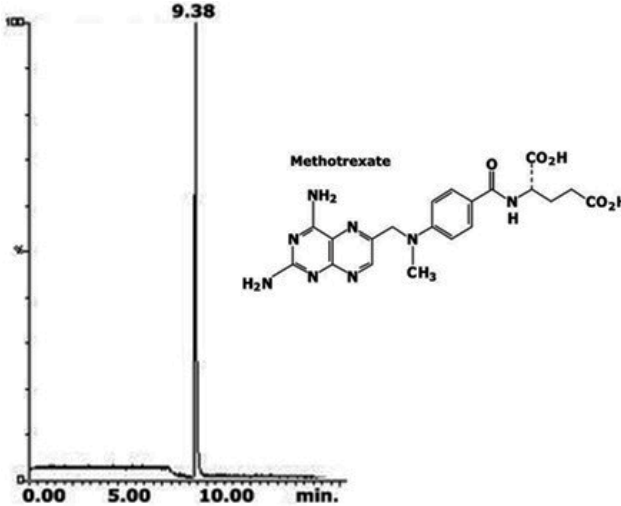
Figure 5. Analysis of methotrexate using a silica hydride C18 stationary phase in the aqueous normal phase mode. Mobile phase: A, DI H 2 O/0.5% formic acid and B, acetonitrile. Gradient: 0–1 min 90% B, 1–5 min to 20% B, 5–10 min 20% B. (http://kb.mtc-usa.com/article/AA-00784/0/).